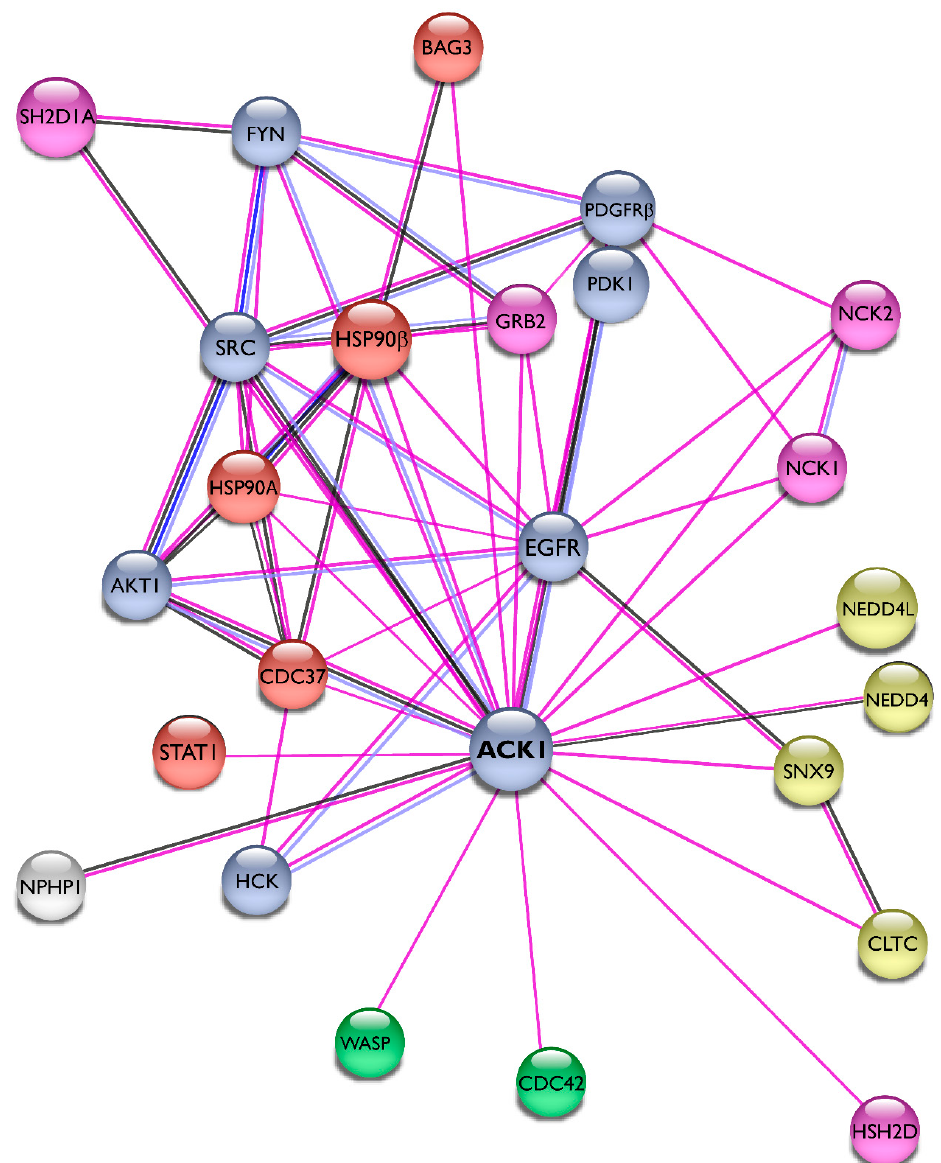
Figure 4. Interaction network of Ack1. Using the STRING database [43], we mapped the Ack1-interacting proteins from Mahajan [44]. Lines are color-coded according to the nature of the association, which is based on experimental evidence (pink), co-expression (dark blue), or protein homology (gray). Nodes are color-coded by function (protein kinases, light blue; adaptor proteins, pink; heat shock protein complex, orange) or signaling networks (actin polymerization, green; receptor endocytosis, yellow).